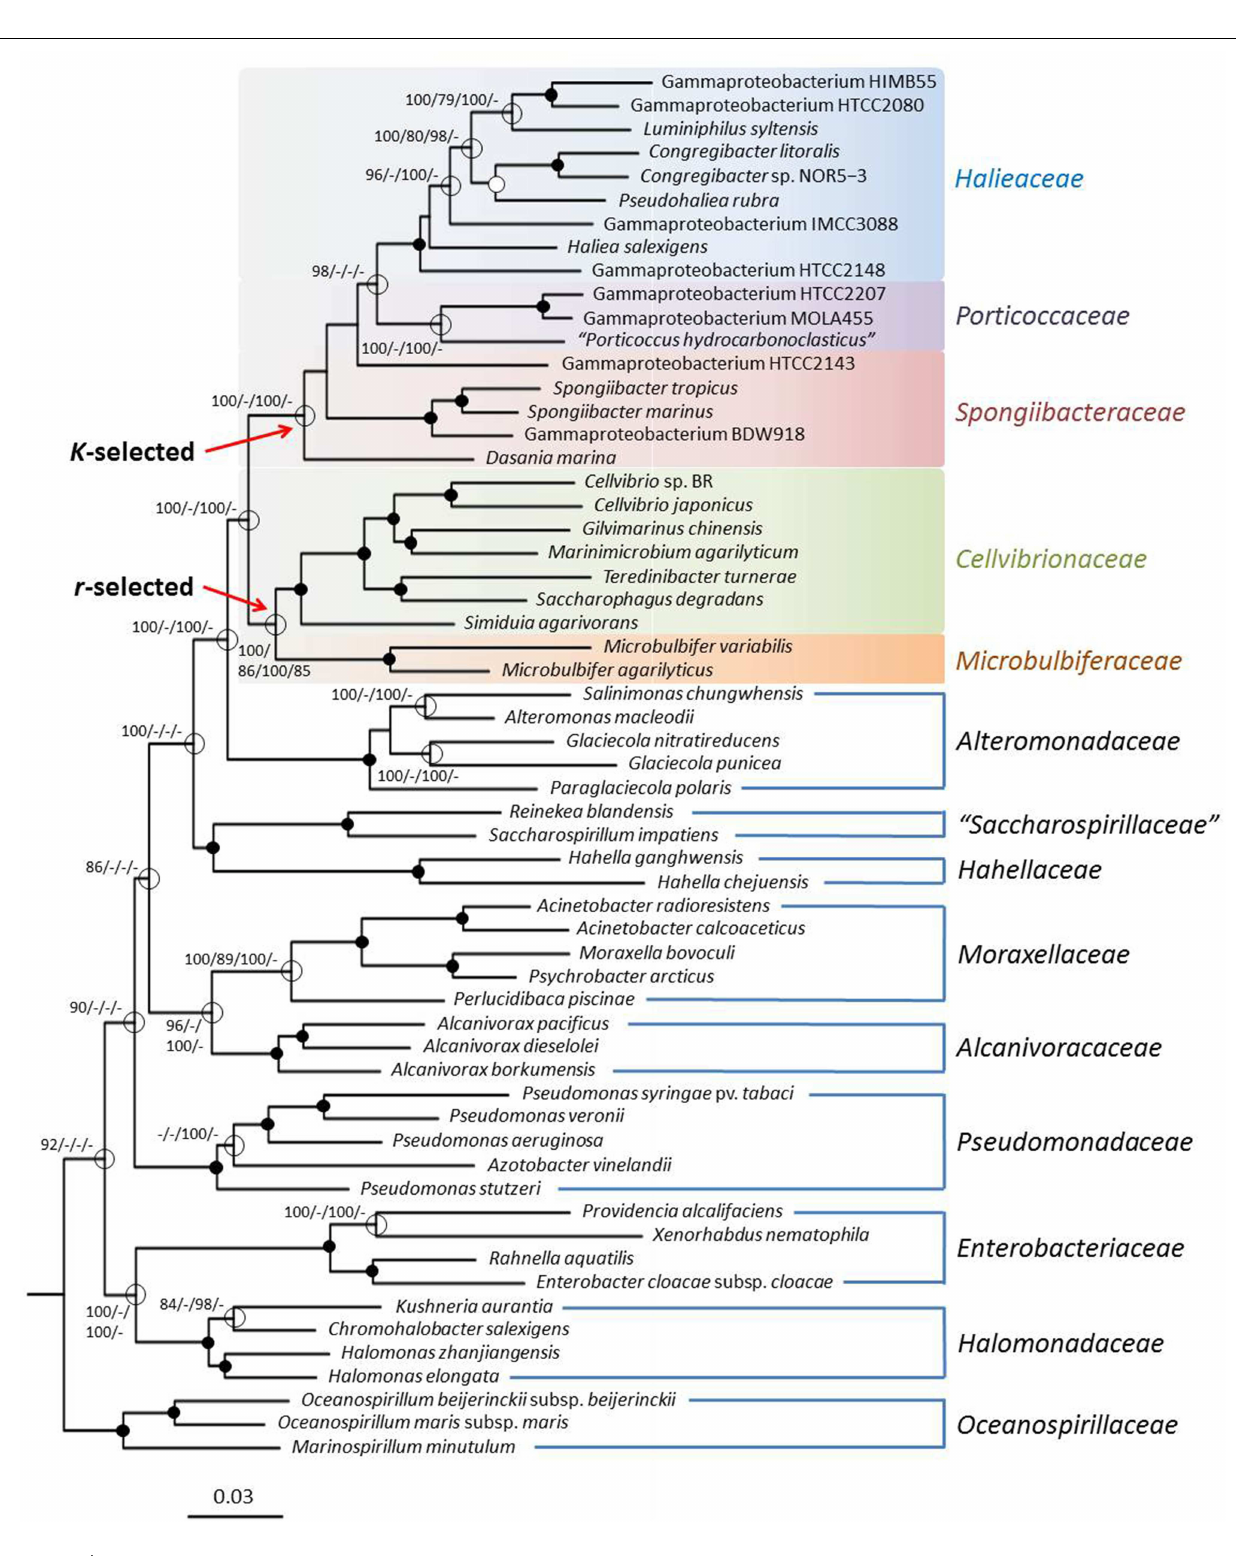
FIGURE 3 | Phylogeny inferred from a gene-content matrix. The tree topology was reconstructed under the maximum likelihood criterion and was rooted with Magnetococcus marinus MC-1 T (not shown). Black dots at a distinct node indicate that bootstrap values of 95% or above (percentages of